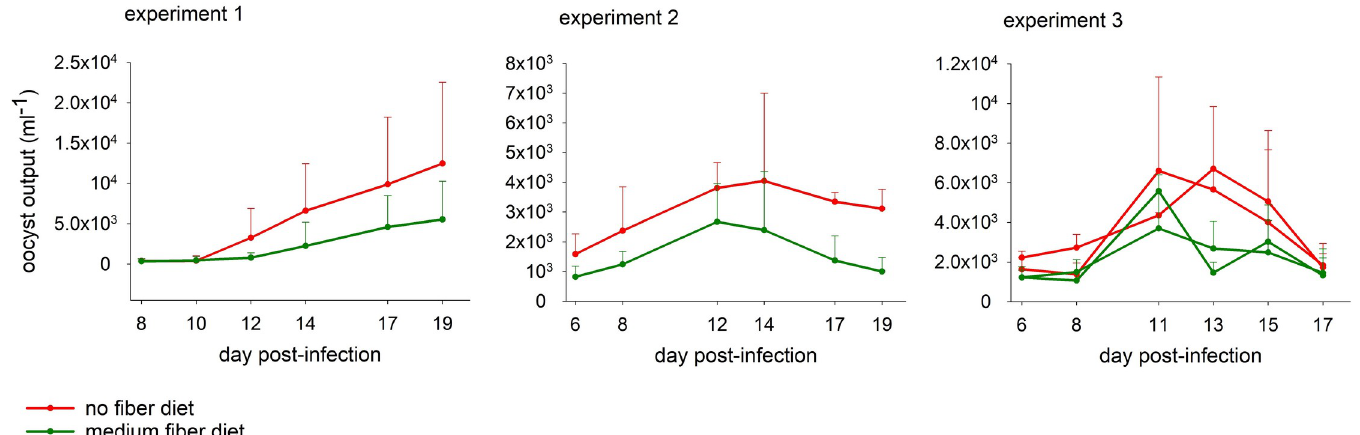
Fig 1. Effect of diet on severity of C . parvum and C . tyzzeri infection. The Y axes show mean overnight oocyst output per ml fecal slurry by group. The mice were sampled individually over a period of approximately 16 h. Values represent mean of 3 mice per group. Experiment 1, C . parvum ; Experiment 2, C . tyzzeri ; Experiment 3, C . tyzzeri . See Table 1 for additional details. Error bars show standard deviation (SD). Color indicates treatment as indicated. One mouse from experiment 1, no-fiber group, remained uninfected for the duration of the experiment and was excluded.